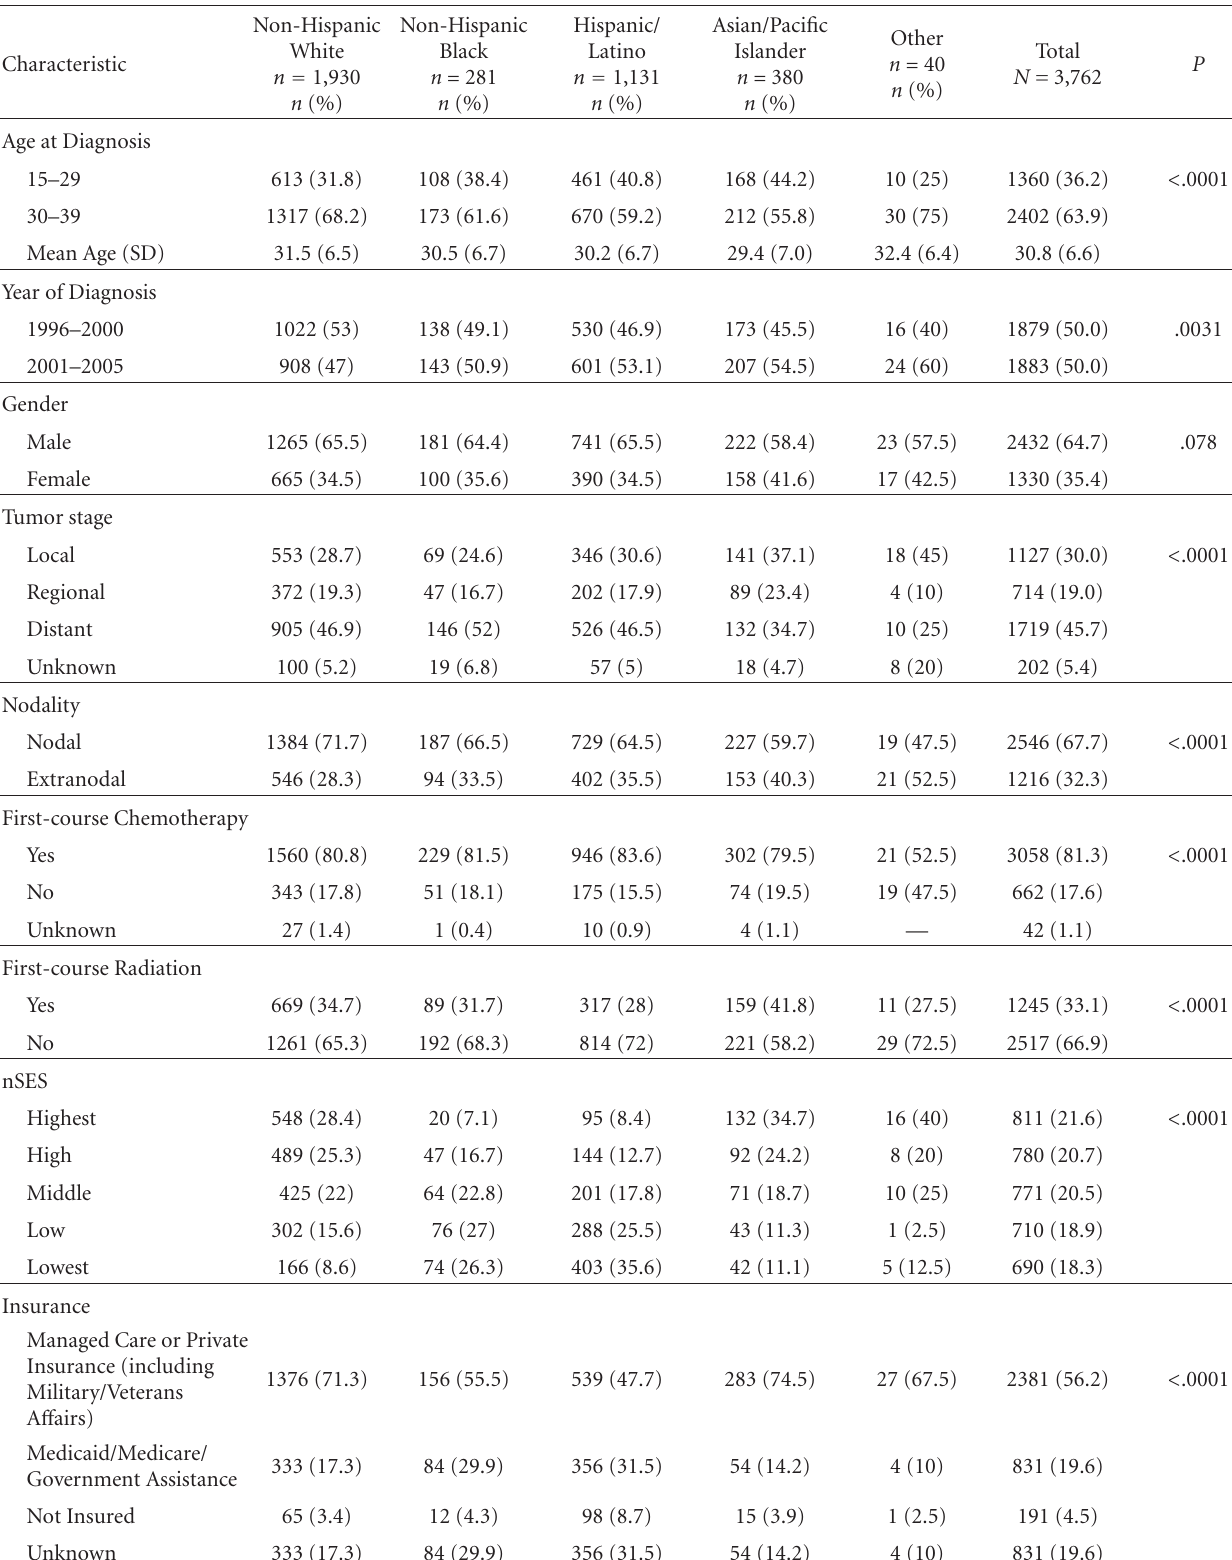
Table 1: Demographic and clinical characteristics of adolescents and young adults diagnosed with non-Hodgkin’s lymphoma a .